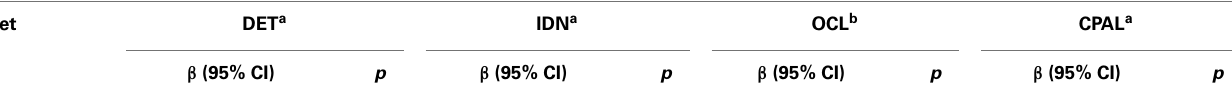
Table 3 | Multiple Regression analyses evaluating (a) breastfeeding and cognitive performance at 17years of age and (b) diet score at 1year and cognitive performance at 17years of age in theWesternAustralian Pregnancy Cohort Study adjusted for sex, family income (age one), father’s presence in the family (age one), maternal age (pregnancy), and maternal education (pregnancy)